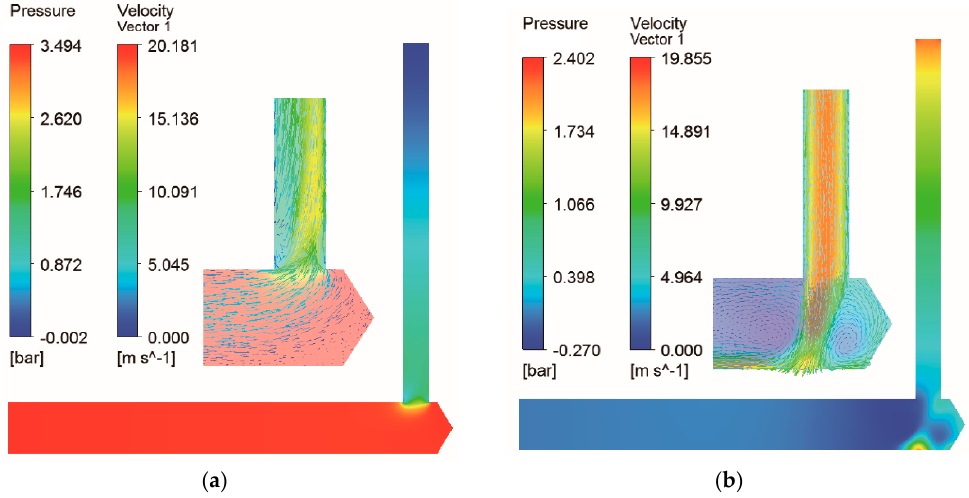
Figure 9. Pressure and velocity distribution when δ 1 = 2: ( a ) contraction and ( b )